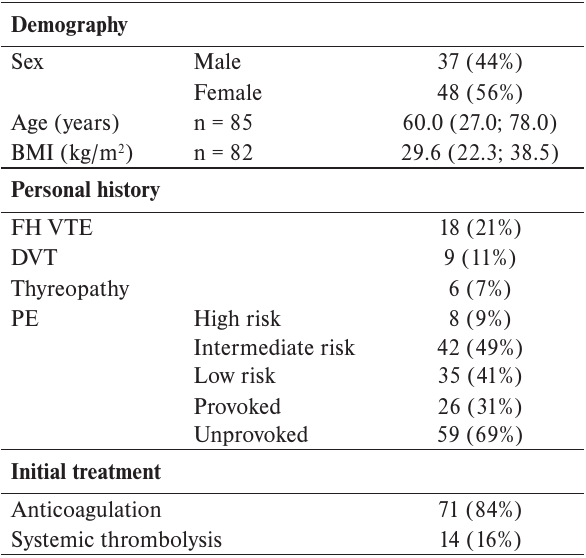
Table 1. Entry characteristics of